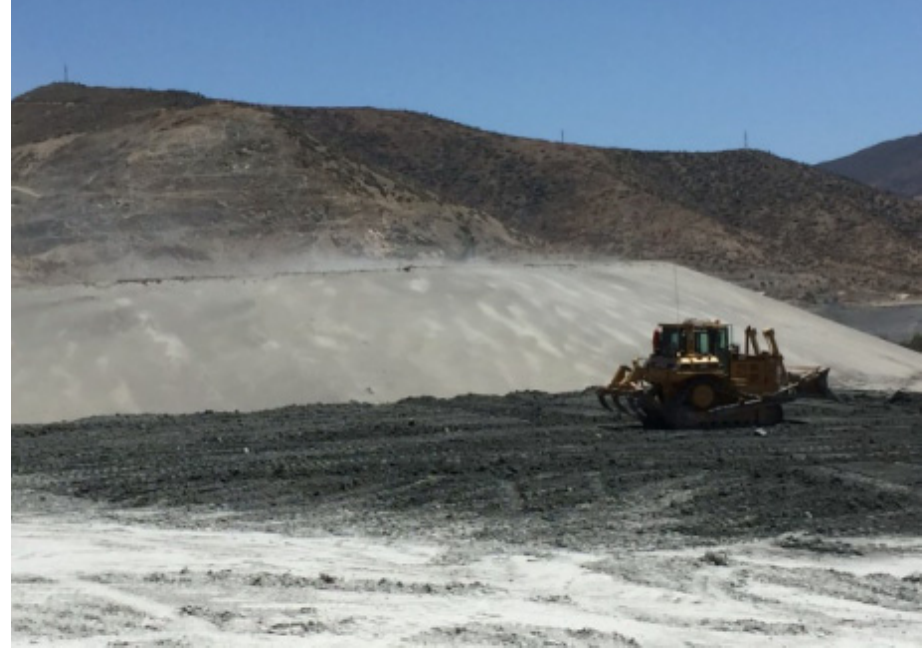
Figure 39. Salares Norte Filtered Tailings Storage Facility–Dozer forming filtered tailings layers [50,64,65].